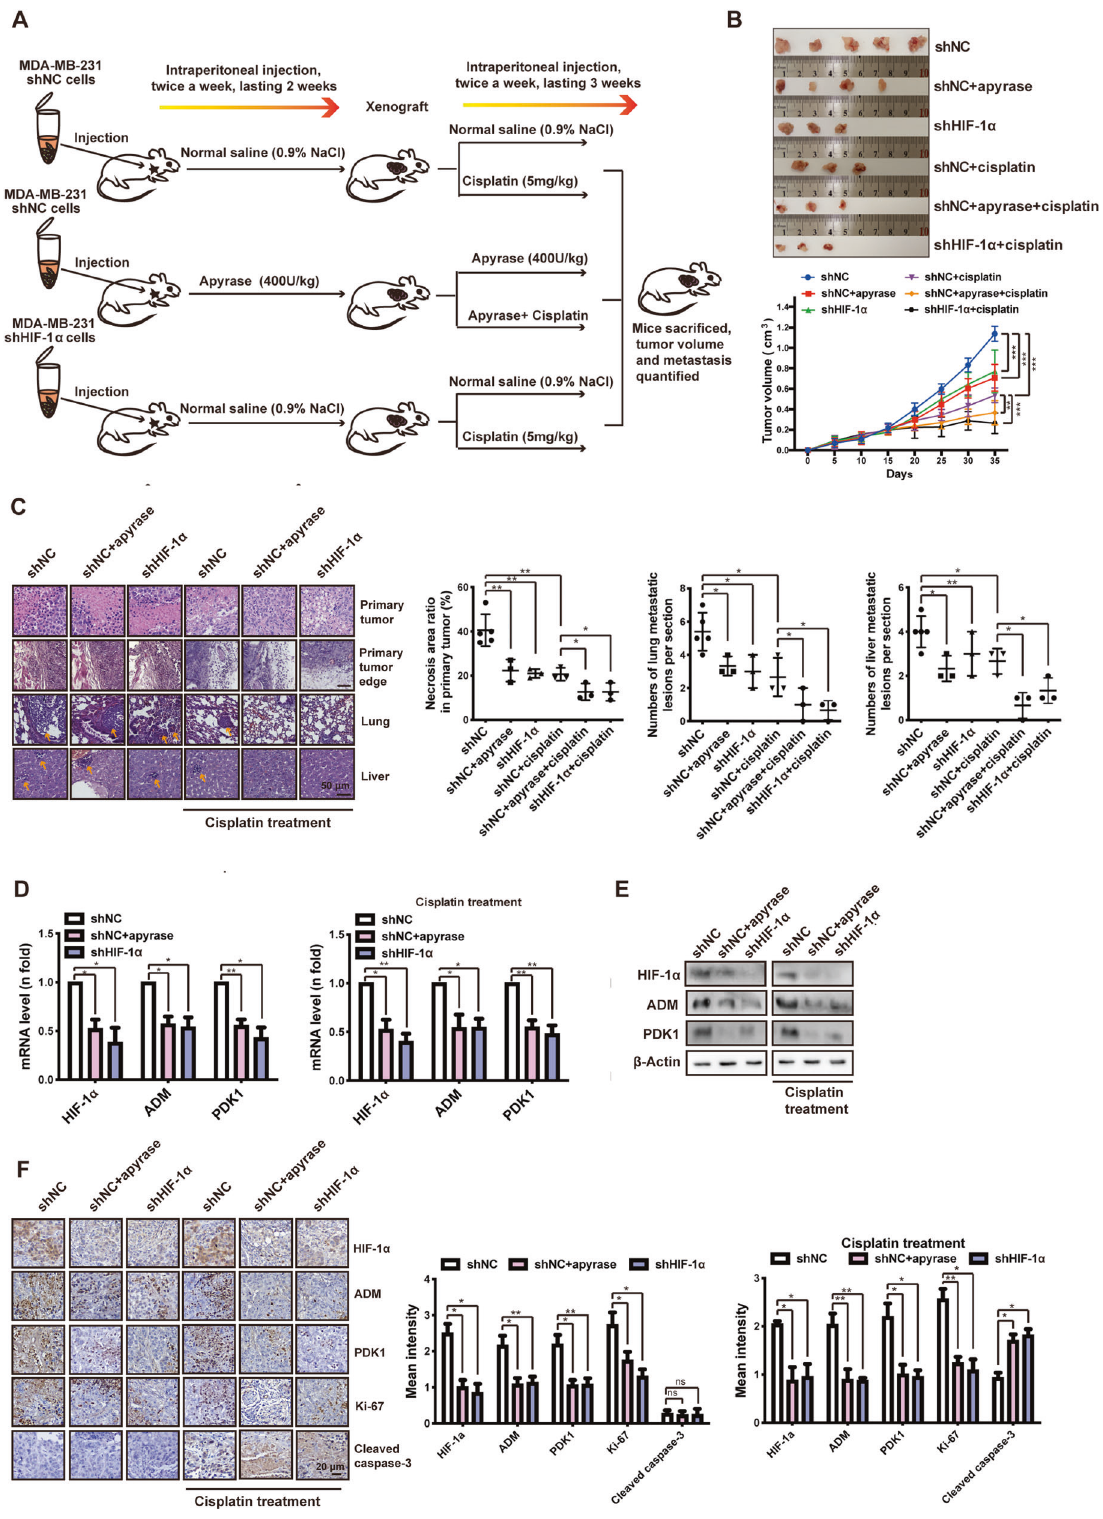
injected into the mammary fat pad of female BALB/c nude mice. Two weeks after inoculation, the tumor volumes reached ~200 mm 3 and mice were randomly divided into fi ve